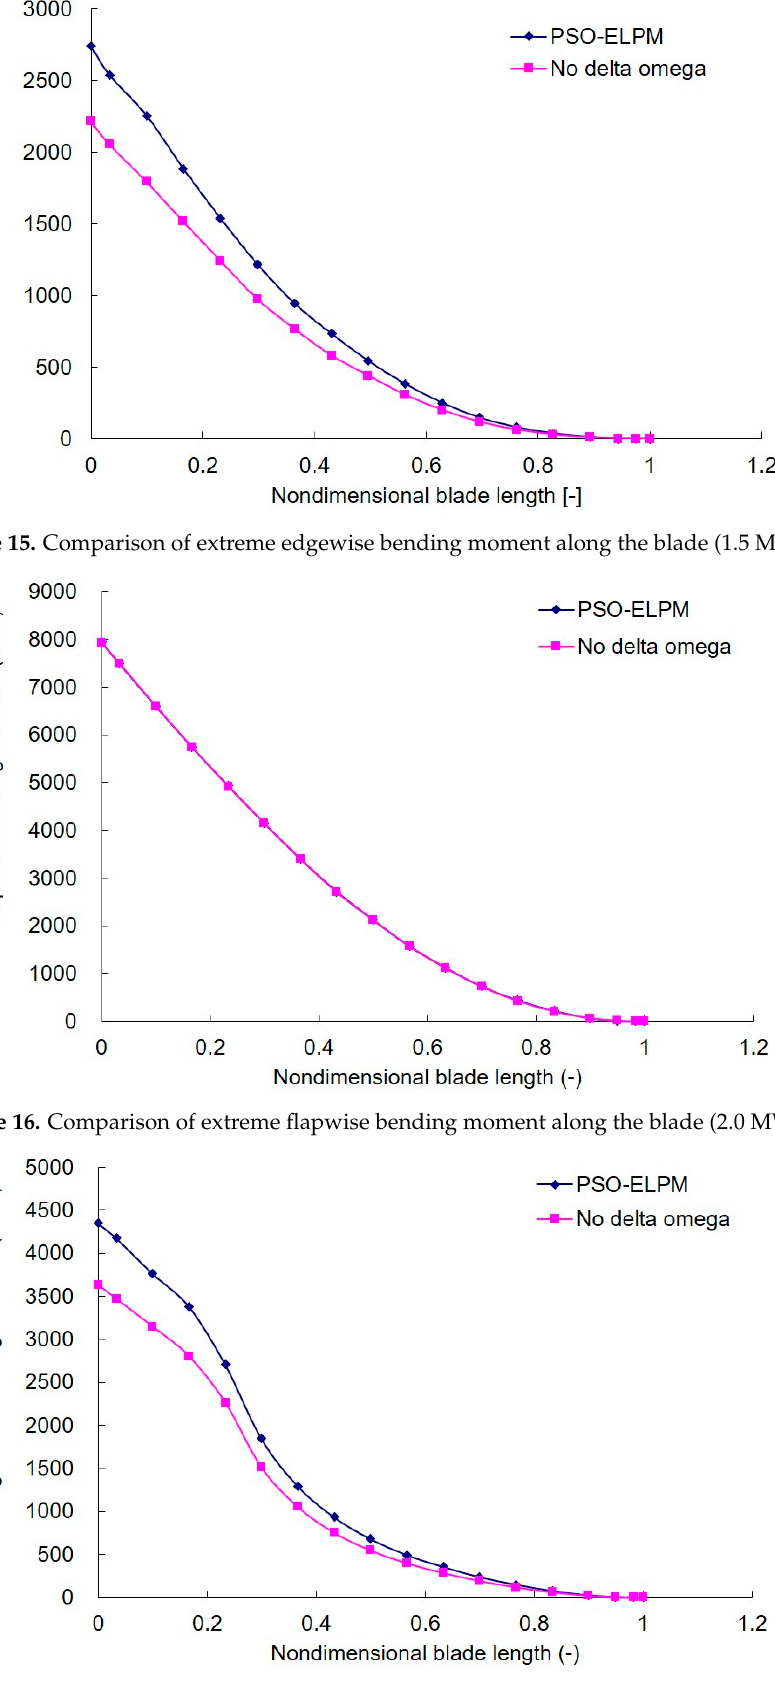
Figure 17. Comparison of extreme edgewise bending moment along the blade (2.0 MW).